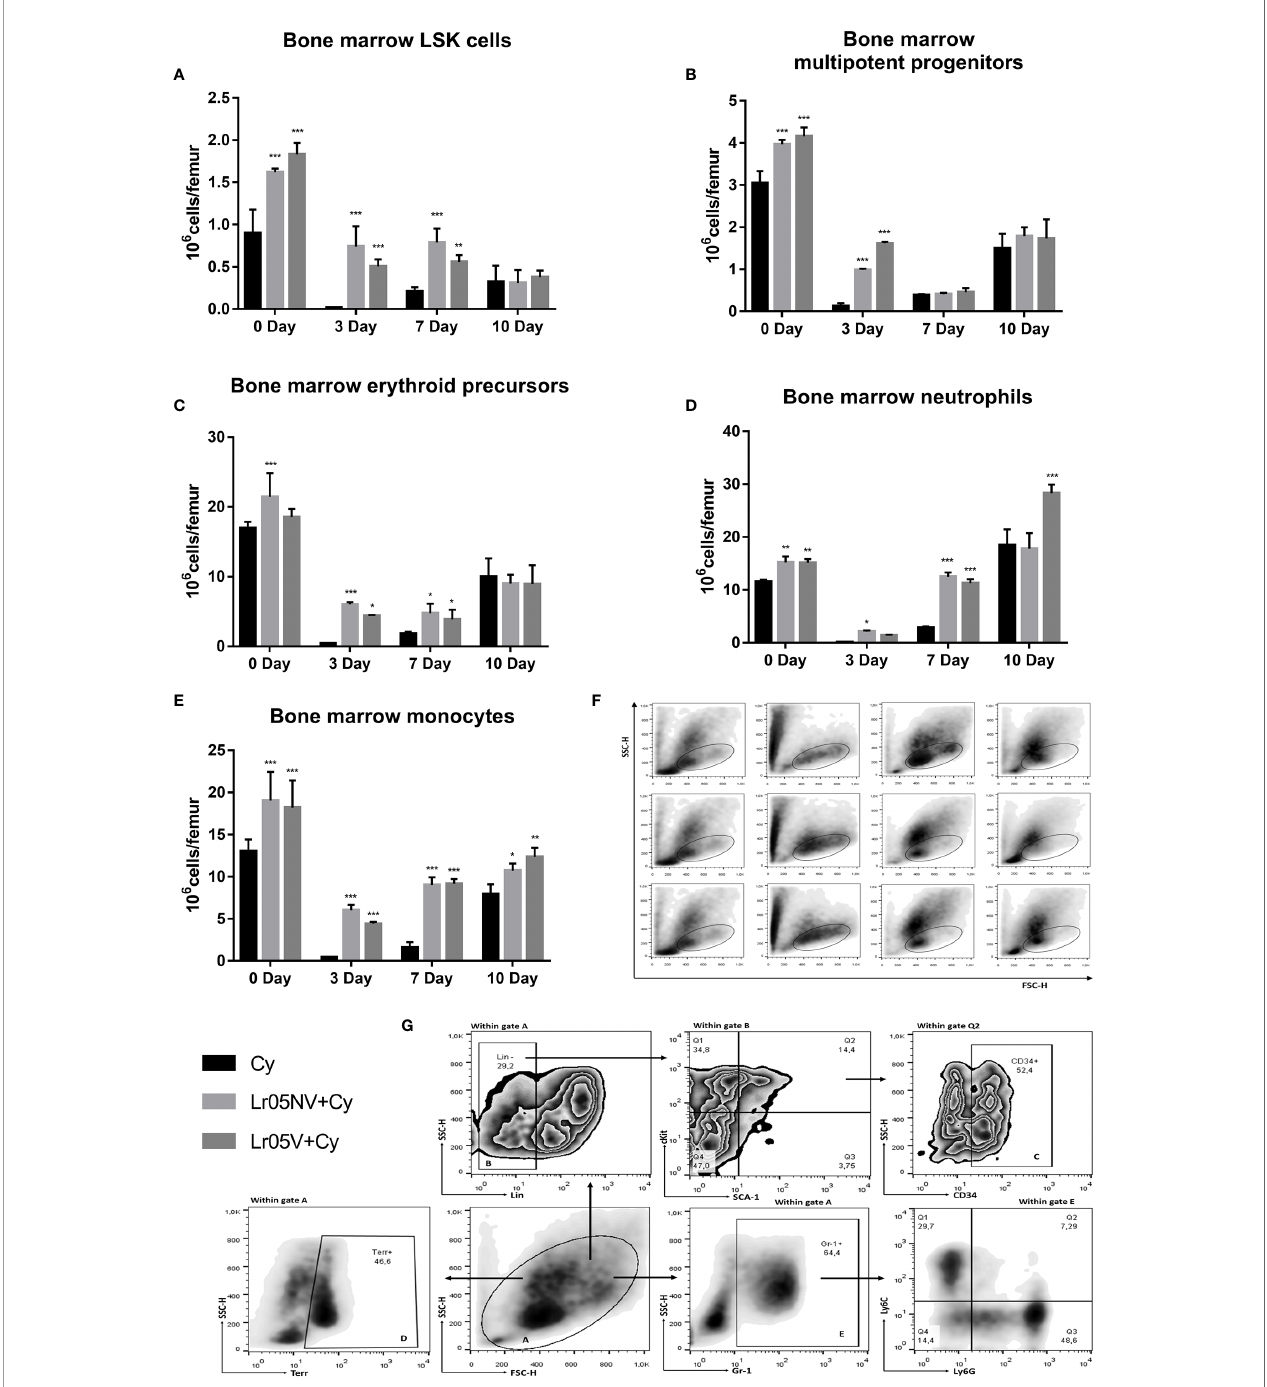
FIGURE 6 | Myelopoietic precursors in bone marrow by fl ow cytometry. 6-week-old Swiss mice were fed with 10 8 cells/mouse/day of viable or non-viable Lactobacillus rhamnosus CRL1505 (Lr05V+Cy or Lr05NV+Cy groups) for 5 consecutive days before injection of Cy. The treated groups and the untreated control mice (Cy group) received one dose of 150 mg/kg Cy intraperitoneally. Bone marrow LSK cells (A) , multipotent progenitors (B) , erythroid precursors (C) , neutrophils (D) , and monocytes (E) were performed on day 0, before Cy administration, and days 3, 7 and 10 post-Cy administration. The results come from two independent experiments. Six animals per group each time were used in the experiments. Results are expressed as mean ± SD. ***,**,* Signi fi cant differences from the Cy group should be as follows (p<0.0001, p<0.002 or p< 0.02 respectively). (F) FSC vs SSC plots belong to days 0, 3, 7 and 10 post-Cy administration in the left-to-right columns, and to the Cy, Lr05V+Cy and Lr05NV+Cy groups in the top-to-bottom rows. (G) Gating strategy to study bone marrow hematopoietic stem cells (LSK) and myeloid linage cells: erythroid precursors, neutrophils and